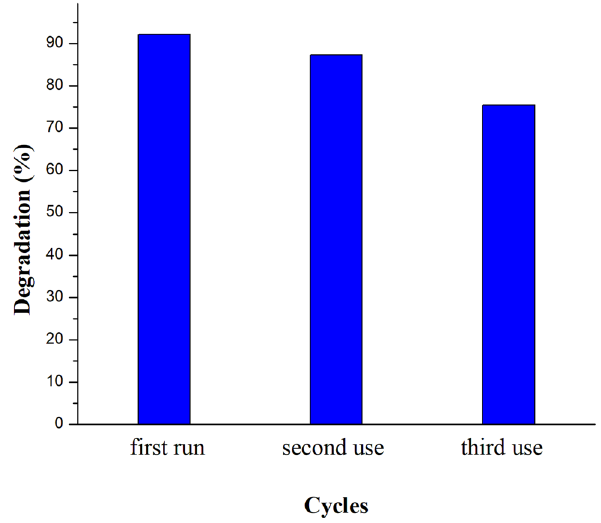
Figure 13: Recycling e ffi ciency of Fe – ZnO - 5 photocatalyst on MO dye degradation under solar